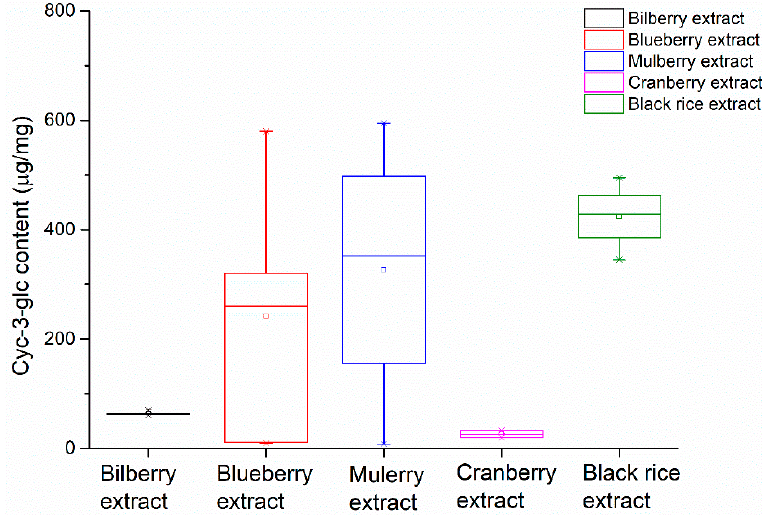
Figure 6. Comparison of the contents of cyanidin-3- O -glucoside in different plant extracts.